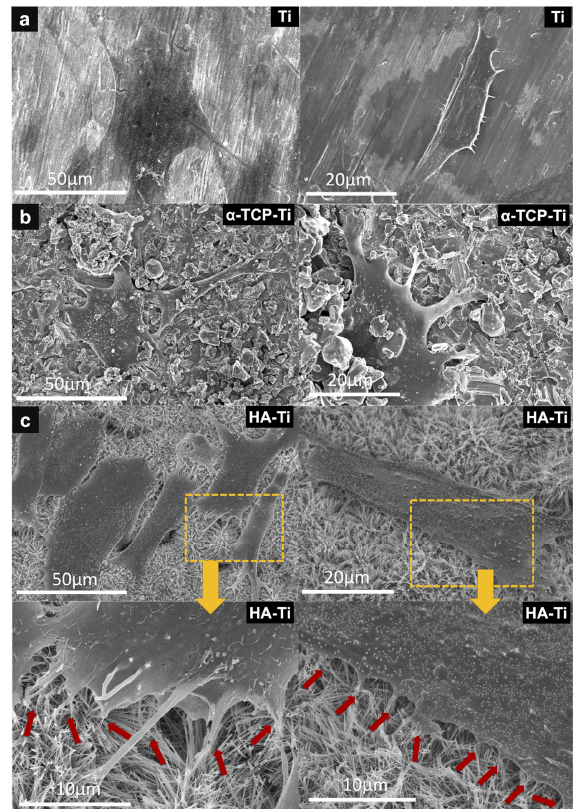
Figure 12. SEM of rat bone marrow mesenchymal stem cells attached to ( a ) Ti, ( b ) α -TCP-Ti, and ( c ) HA-Ti discs after 24 h of culture. Higher magnification images of the area marked by the orange rectangular area in ( c ) clearly revealed the morphology and number of cellular pseudopods on HA-Ti (marked by red arrows).